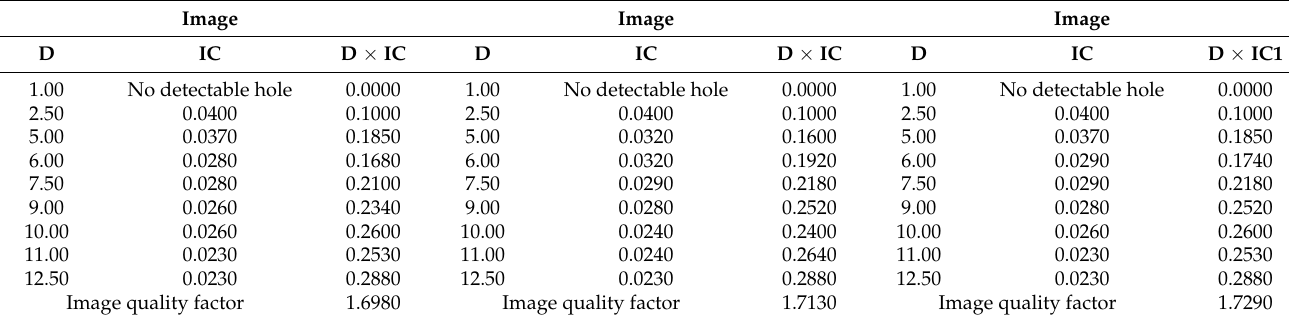
Table 1. The derived image quality factor from the mean values of the image scores verified by single assessors for iodine concentrations (IC, mM) and diameters (D,